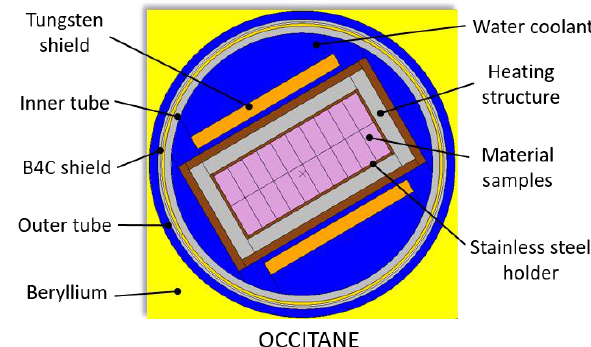
Fig. 3. The OCCITANE test device.